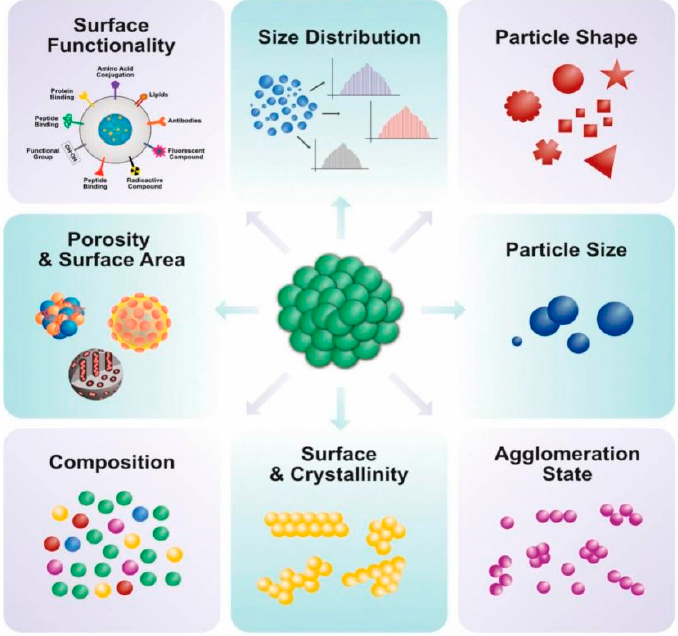
Figure 13. Characteristic features of TiO 2 NPs dependent on characterization, showing the surface functionality, size distribution, particle shape, porosity, surface area, particle size, composition, surface, crystallinity, and agglomeration state [119].